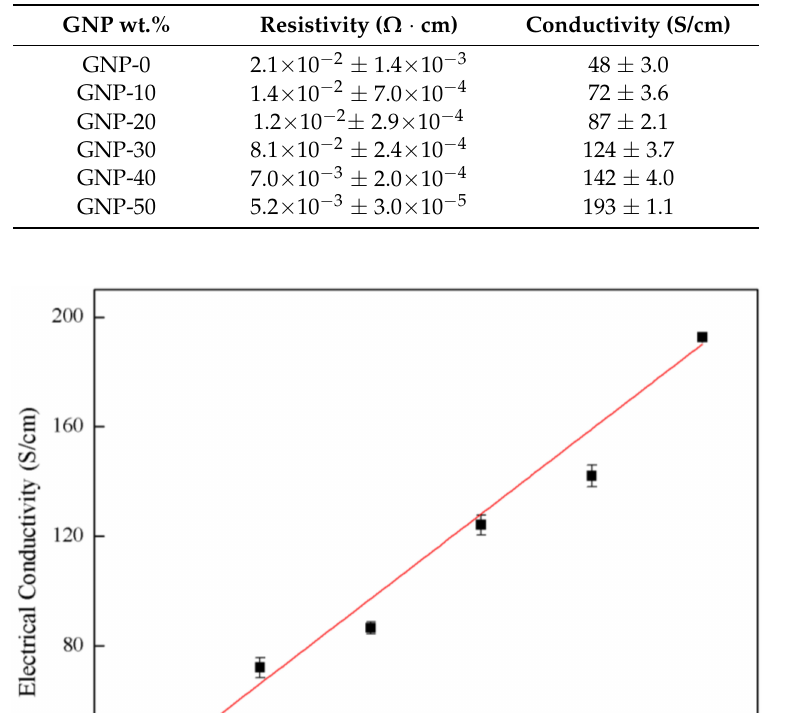
Table 2. Electrical properties of hybrid film with different weight percentage of GNP.